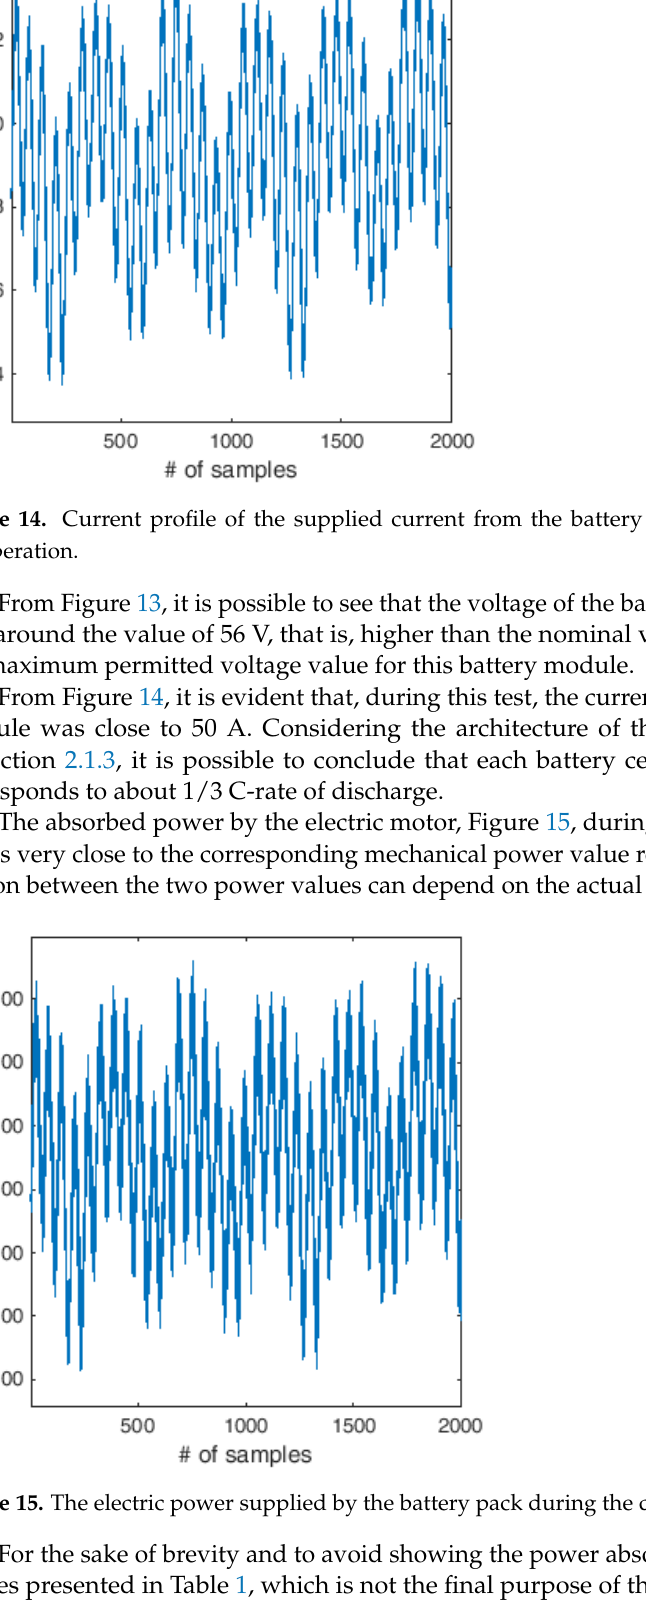
Figure 13. Output voltage profile of the battery pack during the dumpster lift operation.